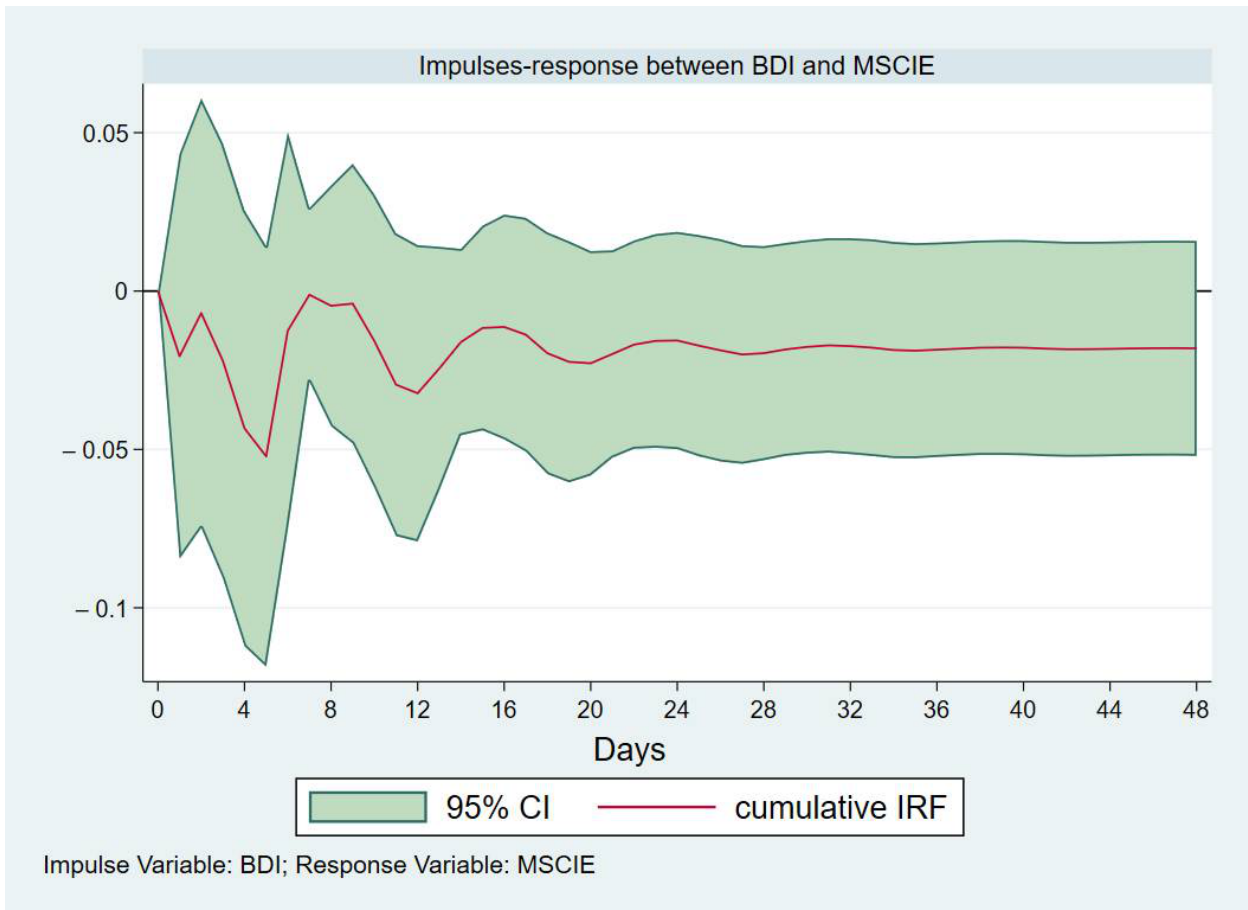
Figure 9. Cumulative impulse response of MSCIE to BDI. Note: The red line represents the estimates, while green bands represent lower and upper bounds to the 95% confidence intervals.